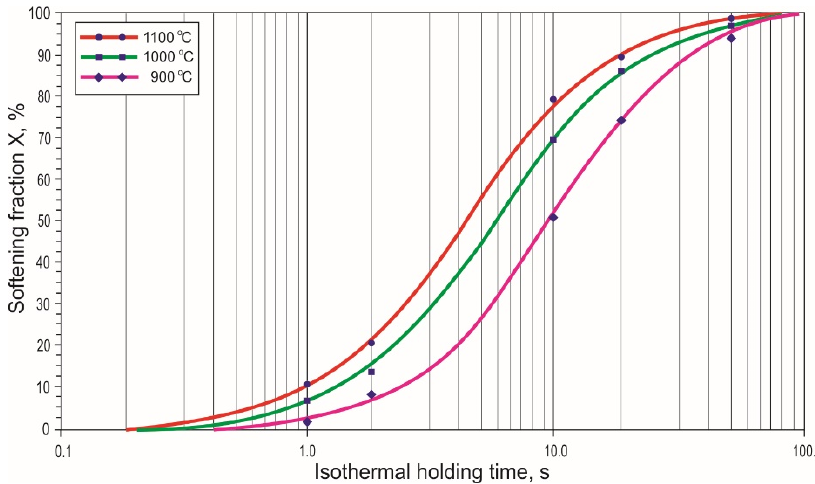
Figure 5. Influence of temperature on the kinetics of static recrystallization in the hot compression test; strain rate 10 s − 1 . test; strain rate 10 s − 1